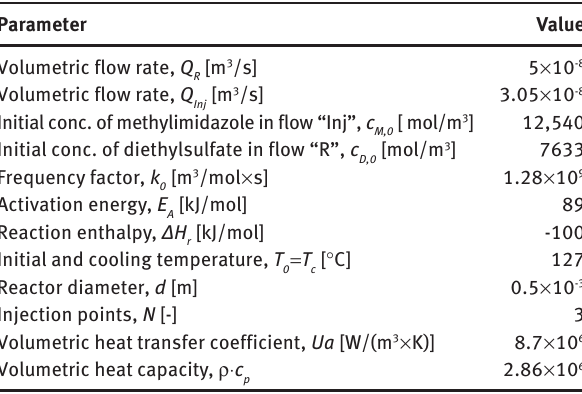
Table 1 Parameters used for the simulation of a multi-injection reactor [12].